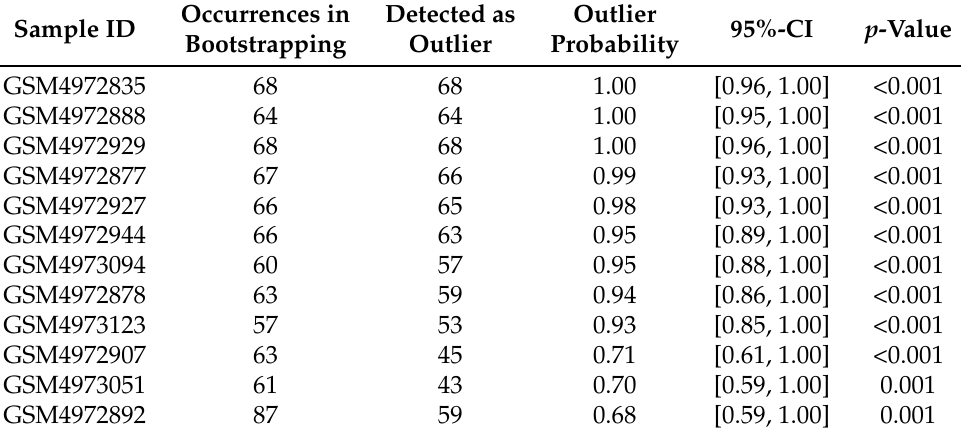
Table 2. Twenty samples most frequently detected as outliers in the SARS-CoV-2 dataset during bootstrap–bagplot analysis. In addition to sample ID, the number of occurrences in 100 bootstrap runs and the number of bootstrap runs the sample was detected as outlier are presented. Furthermore, the estimated outlier probability with a 95%-confidence interval and the p -value from the binomial test are